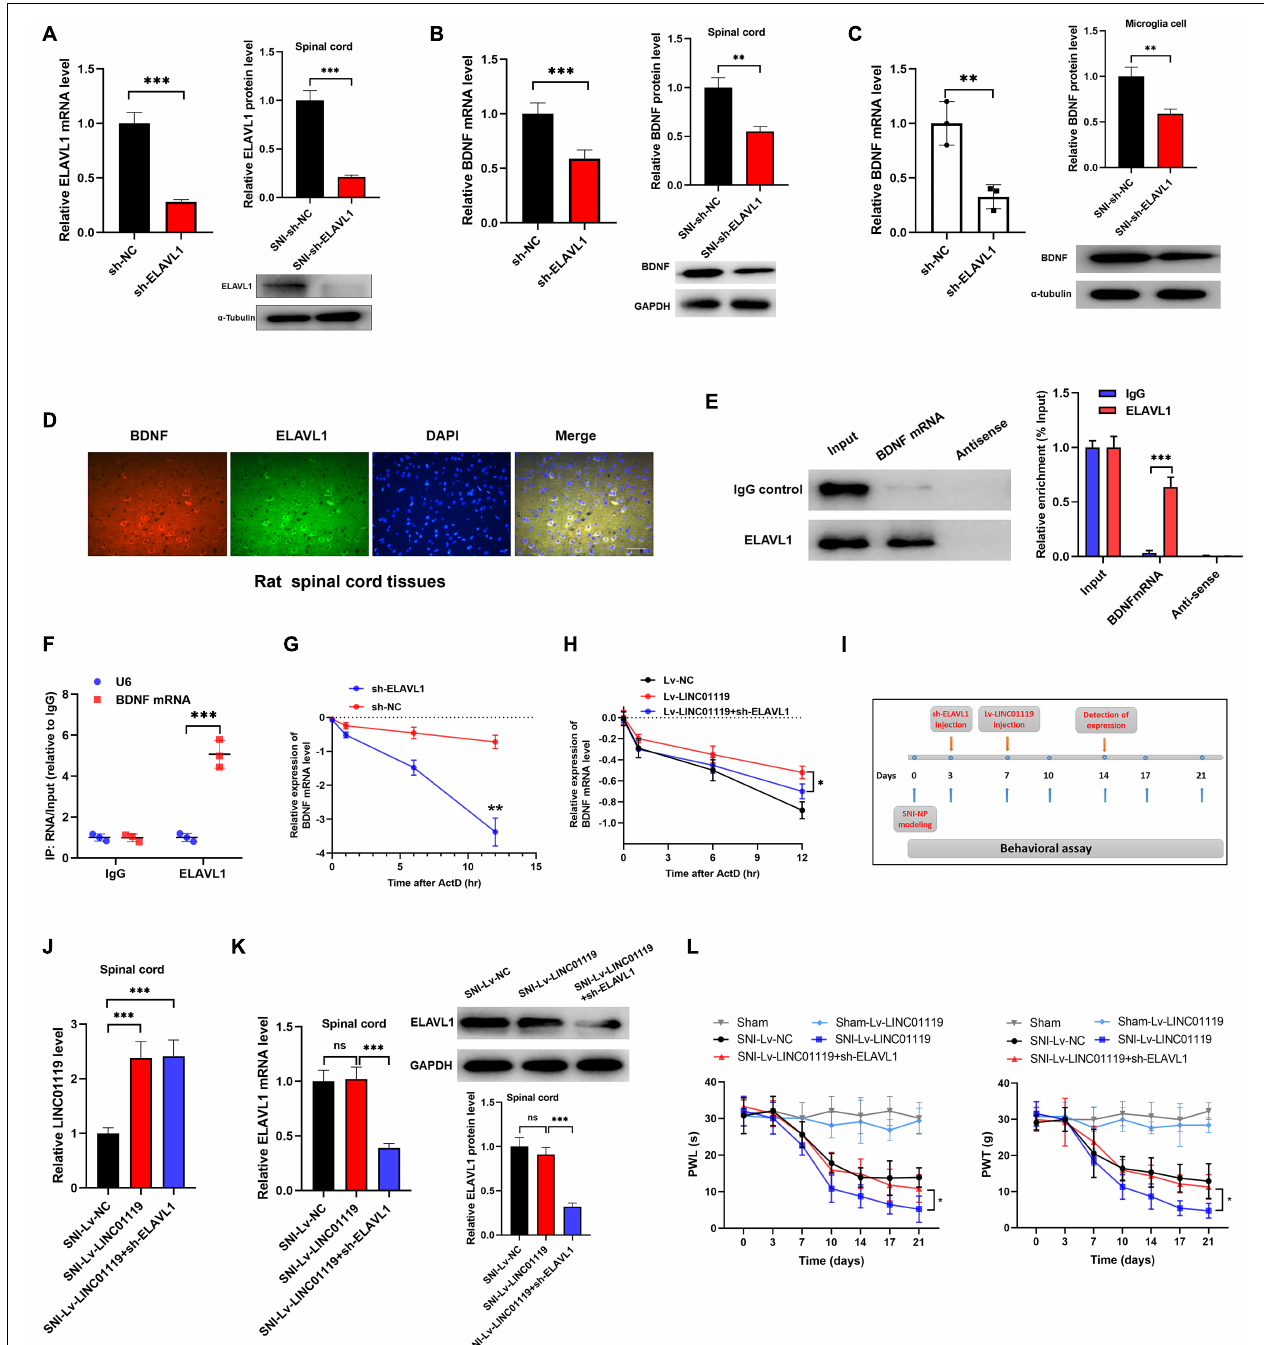
FIGURE 5 | LINC01119-ELAVL1 complex stabilizes BDNF mRNA, thereby inducing NP in SNI rats. (A) ELAVL1 was silenced in spinal cord tissue of SNI rats at both transcript and protein levels, *** P < 0.001, n = 8/group. (B) BDNF was downregulated in spinal cord tissue of SNI rats silenced with ELAVL1 at both transcript and protein levels, *** P < 0.001, n = 3/group. (C) Knockdown of ELAVL1 induced inhibition of BDNF expression in rat microglial cells, ** P < 0.01. (D) Immunofluorescence showed the co-expression of ELAVL1 and BDNF protein in spinal cord tissue of SNI rats. Scare bar = 100 µ m. (E) RNA pulldown assay showed that ELAVL1 protein was interacted with BDNF mRNA in spinal cord tissues, *** P < 0.001, n = 3/group. (F) RIP assay with ELAVL1 antibody in spinal cord showed a significantly higher enrichment of BDNF mRNA compared to U6, *** P < 0.001, n = 3/group. (G) The half-life of BDNF RNA was dramatically decreased in ELAVL1-silenced cells compared to that in control cells, *** P < 0.001. (H) Knockdown of ELAVL1 reversed the LINC01119-mediated RNA stability of BDNF in microglia cells, * P < 0.05. (I) The flow chart of manipulations of respective lentivirus vectors in SNI rats. (J,K) Expressions of LINC01119 (J) and ELAVL1 (K) in groups received respective manipulations, *** P < 0.001, n = 3/group. (L) PWL and PWT assays showed that knockdown of ELAVL1 abrogated LINC01119-induced NP behaviors, * P < 0.05, n = 5/group.